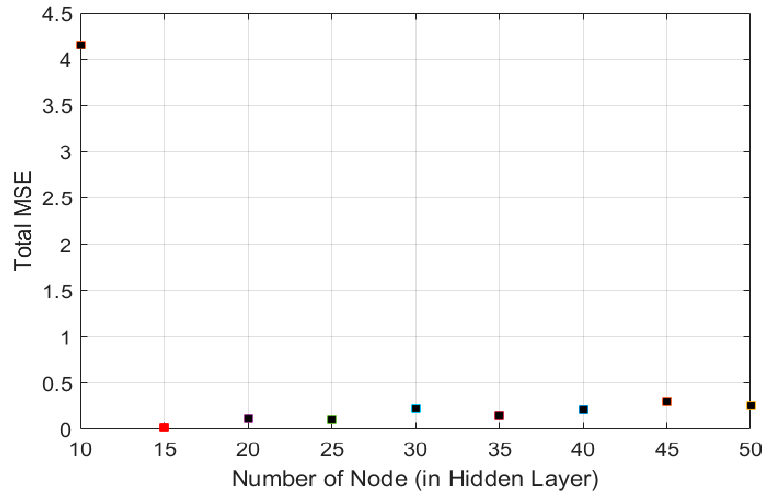
Figure 5. Selection of the number of nodes or neurons in the hidden layer for the ANN determination of the liquid, gas and tar.